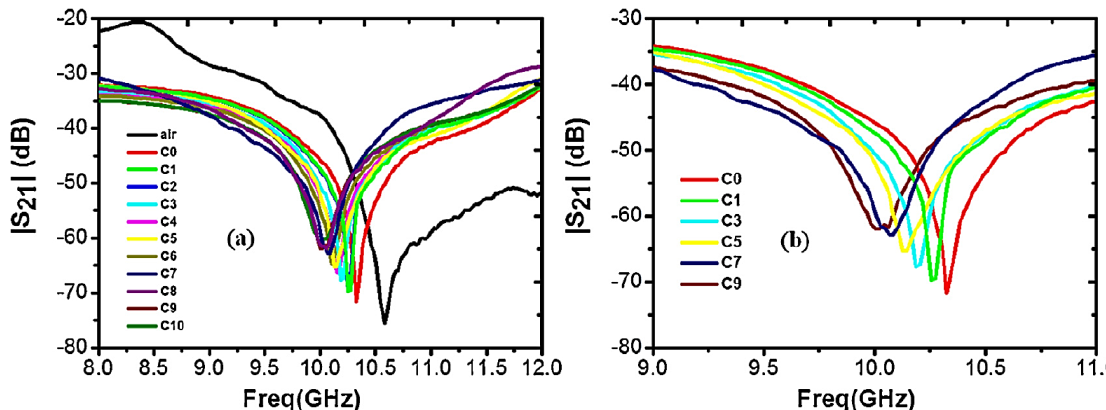
Figure 15. ( a ) Experimental S 21 parameters of the sensor recorded in the X-band as a function of different concentrations of NaCl; and ( b ) zoom of ( a ), with selected concentrations to highlight the variation in the position of the resonant frequency and the magnitude of attenuation when the concentration is increased [68].